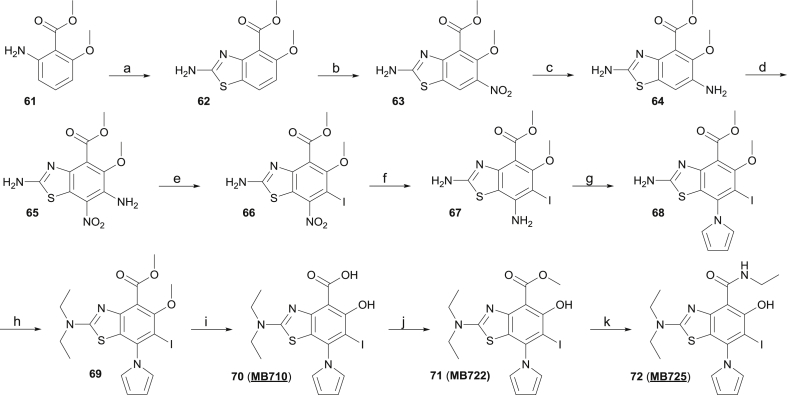
Synthesis of substituted aminobenzothiazole derivative 70–72.aaConditions: (a) KSCN, Br2, AcOH, 10 °C, 43%; (b) HNO3,0 °C, 91%; (c) SnCl2·2H2O, CH2Cl2/AcOEt, 0 °C to rt, 58%; (d) KNO3, TFA, rt, 80%; (e) NaNO2, aq. HCl, 0 °C, then KI, rt, 80%; (f) Fe, AcOH, 50 °C, 92%; (g) 2,5-dimethoxytetrahydrofuran, AcOH, 120 °C, 19%; (h) EtI, K2CO3, DMF, 60 °C, 48%; (i) BBr3, CH2Cl2, 0 °C to rt, 79%; (j) DCC, DMAP, MeOH, rt, 92%; (k) 70% aq. EtNH2, rt, 95%.